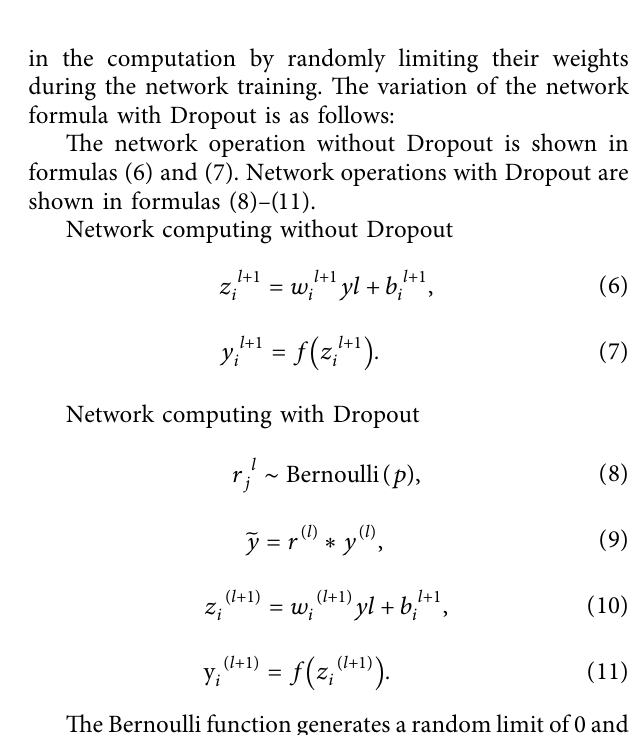
Figure 6: Convolutional operation